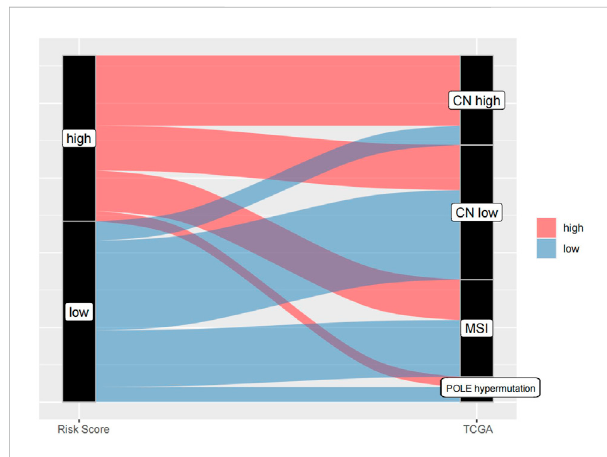
FIGURE 13 Validation of Risk Score Model and TCGA molecular